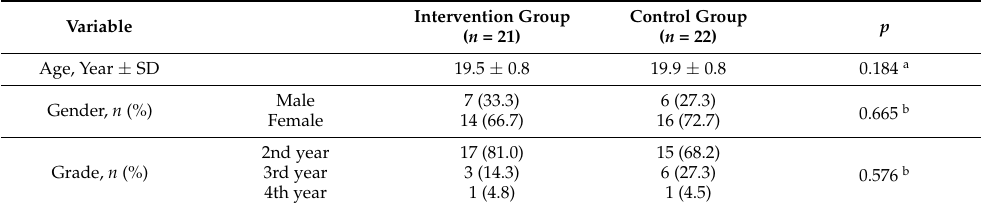
Table 2. Demographic characteristics of the sample ( n = 43).